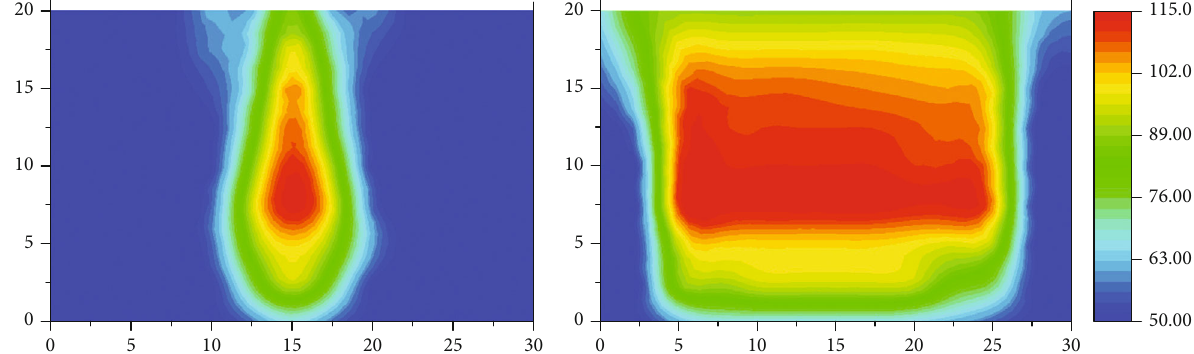
Figure 9: Temperature fi eld in the 3D model during the early stage of Experiment 2: (a) in the vertical direction of the wells and (b) along the wells.